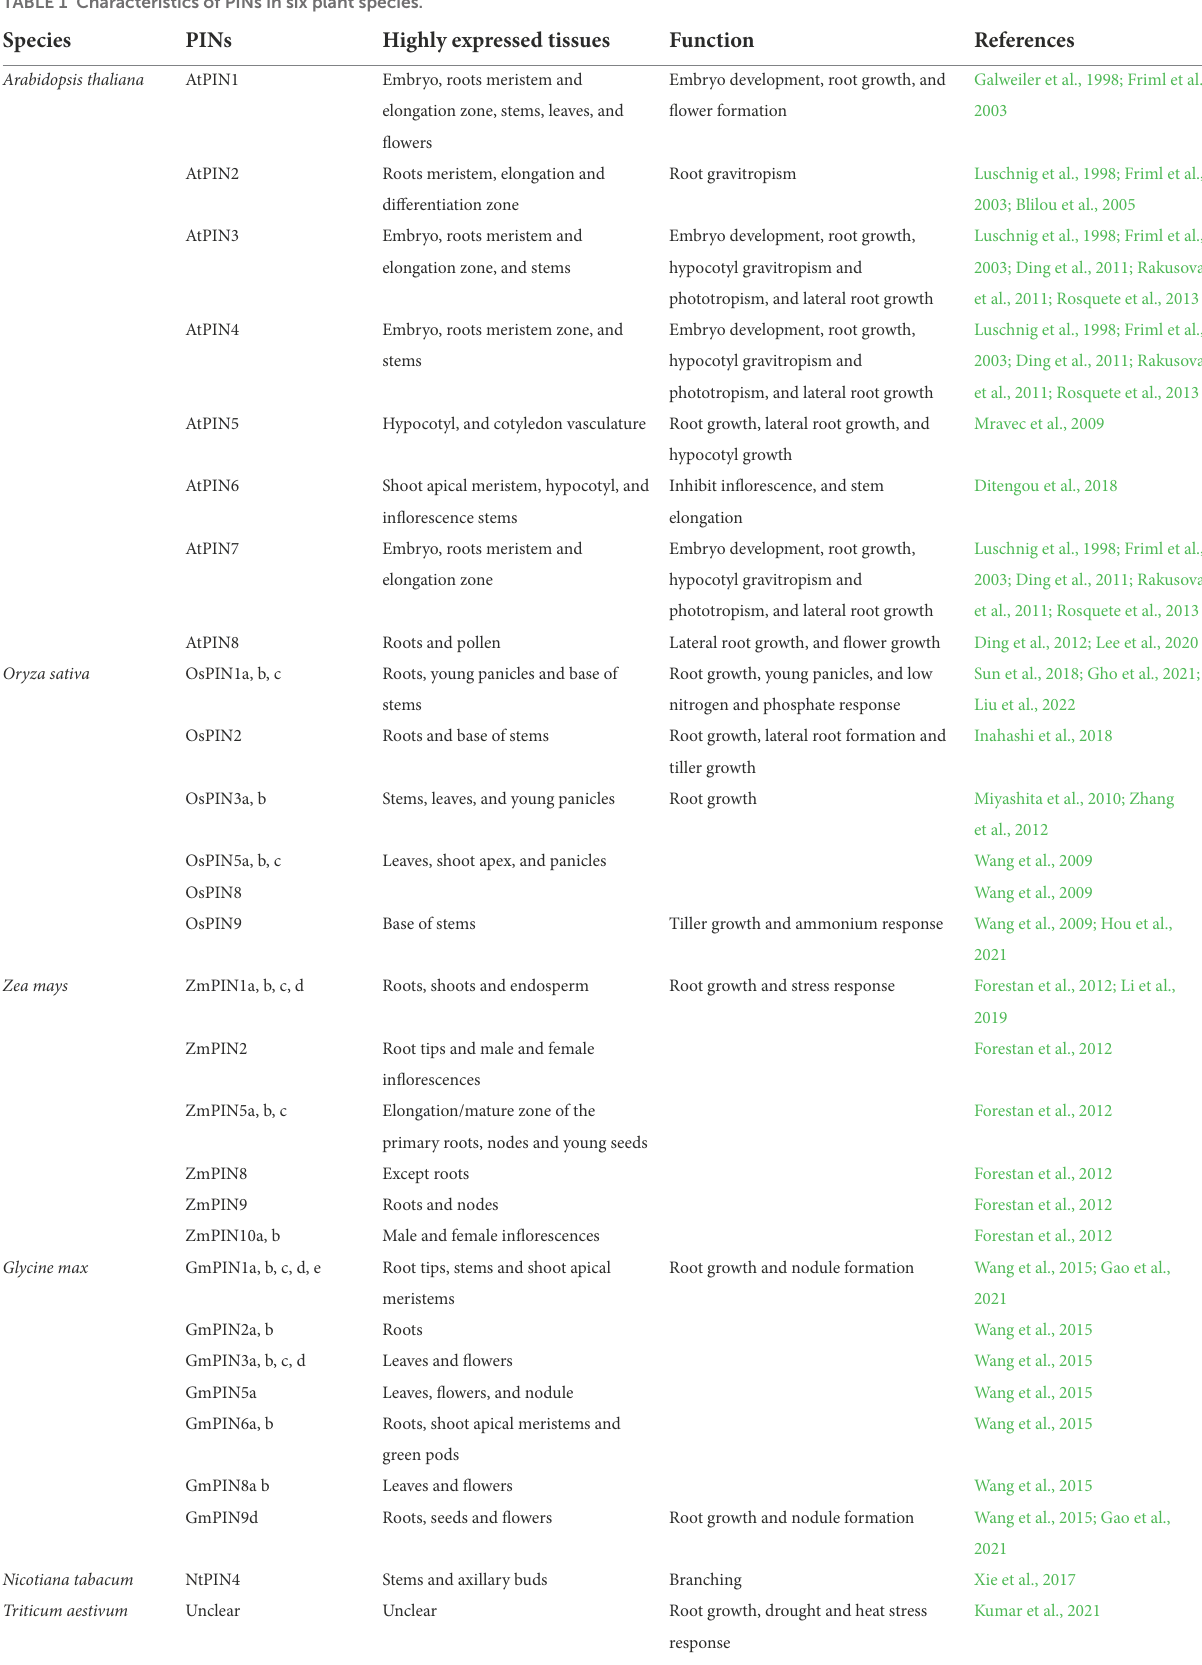
TABLE 1 Characteristics of PINs in six plant